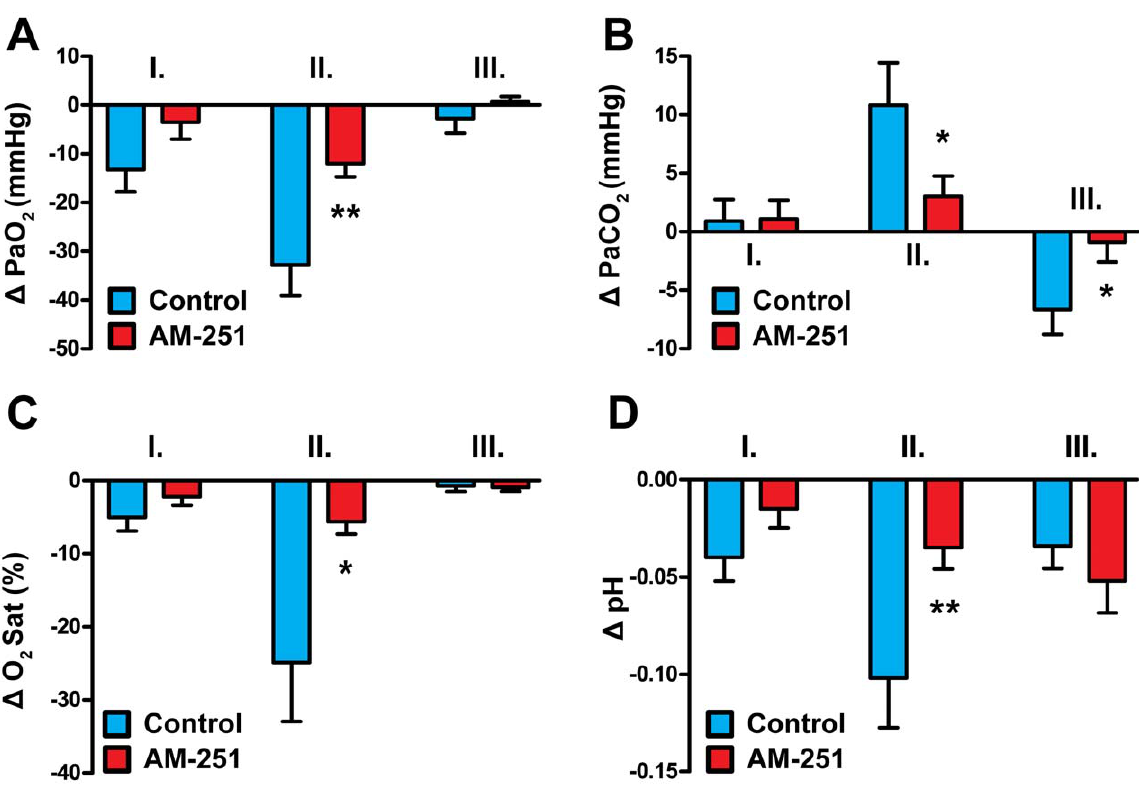
Figure 4. Effects of AM-404 on arterial blood gases and pH before and after AM-251 treatment. Arterial blood-gas and pH changes are shown in phases I, II and III of the AM-404 (10 mg kg 2 1 , i.v.) response before and after treatment with AM-251 (10 mg kg 2 1 , i.v.). Values are means 6 SEM and are expressed as changes from baseline (see Table 2); *P , 0.05, **P , 0.01, versus ‘‘Before AM-251’’, n=10.